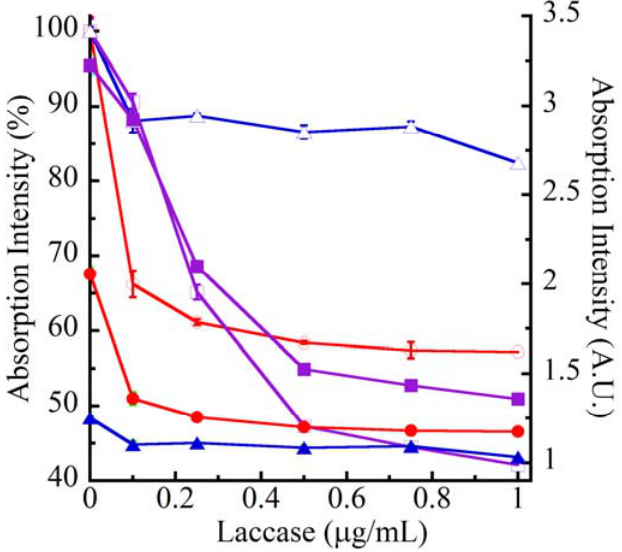
Figure 1B. Laccase dose-response profiles for CA oxidation monitored by 290 nm absorption. Increasing concentrations of laccase were used to oxidize 500  M CA in 100  L of pH 4.5 buffer using UV-transparent 96-well microplate. At 60 min, the reactions were stopped through basification (100 mM NaOH final). Decreases in absorbance were measured from the CA samples purchased from Alfa Aesar (open and closed triangles, blue tracings), Acros Organics (open and closed circles, red tracings) and Sigma-Aldrich (open and closed squares, purple tracings). Open symbols represent normalized percent decreases in the absorption intensity and closed symbols are the actual absorption units